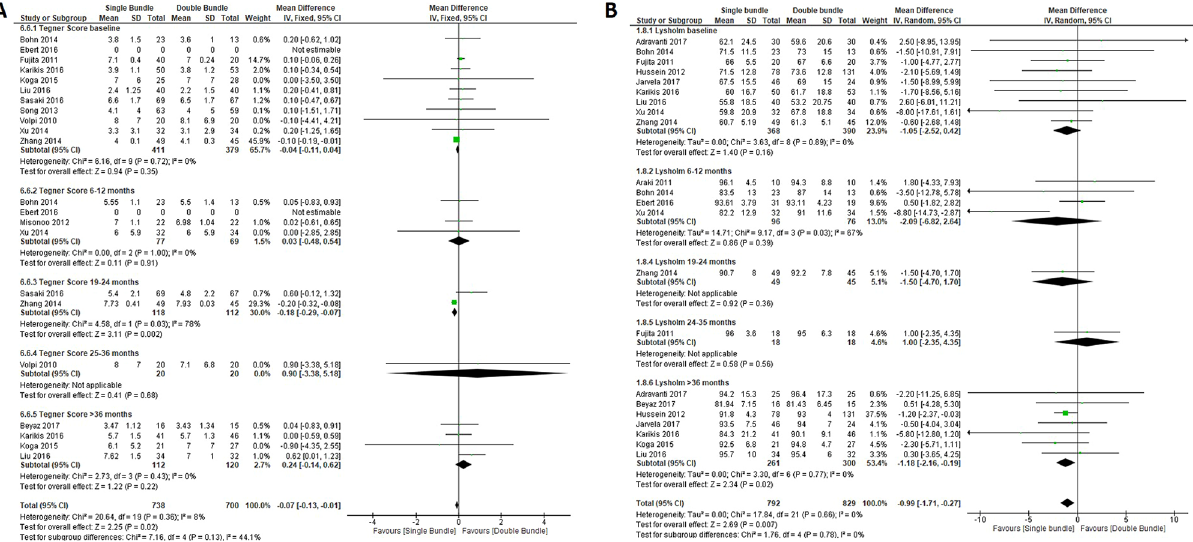
Figure 4. Return to pre-injury level data forest plot outcomes for single-bundle versus double-bundle reconstruction. Weights from fixed effects for the Tegner score analysis and random effects for the Lysholm score analysis are presented. ( A ) Continuous data for the Tegner score (10 studies in the baseline period, 790 patients; 4 studies in the 6–12-month period, 146 patients; 2 studies in the 19–24-month period, 230 patients; 1 study in the 25–36-month period, 40 patients and 4 studies in the > 36-month period, 232 patients). Heterogeneity was low: χ 2 = 20.64, df = 19 ( P = 0.36); I 2 = 8% (CI, confidence interval; IV, inverse variance). ( B ) Continuous data for the Lysholm score (9 studies in the baseline period, 758 patients; 4 studies in the 6–12- month period, 172 patients; 1 study in the 19–24-month period, 94 patients; 1 study in the 25–36-month period, 36 patients and 7 studies in the > 36-month period, 561 patients). Heterogeneity was low: τ 2 = 0.00; χ 2 = 17.84, df = 6 ( P = 0.66); I 2 = 0% (CI, confidence interval; IV, inverse variance). Data collected from RevMan 5.3